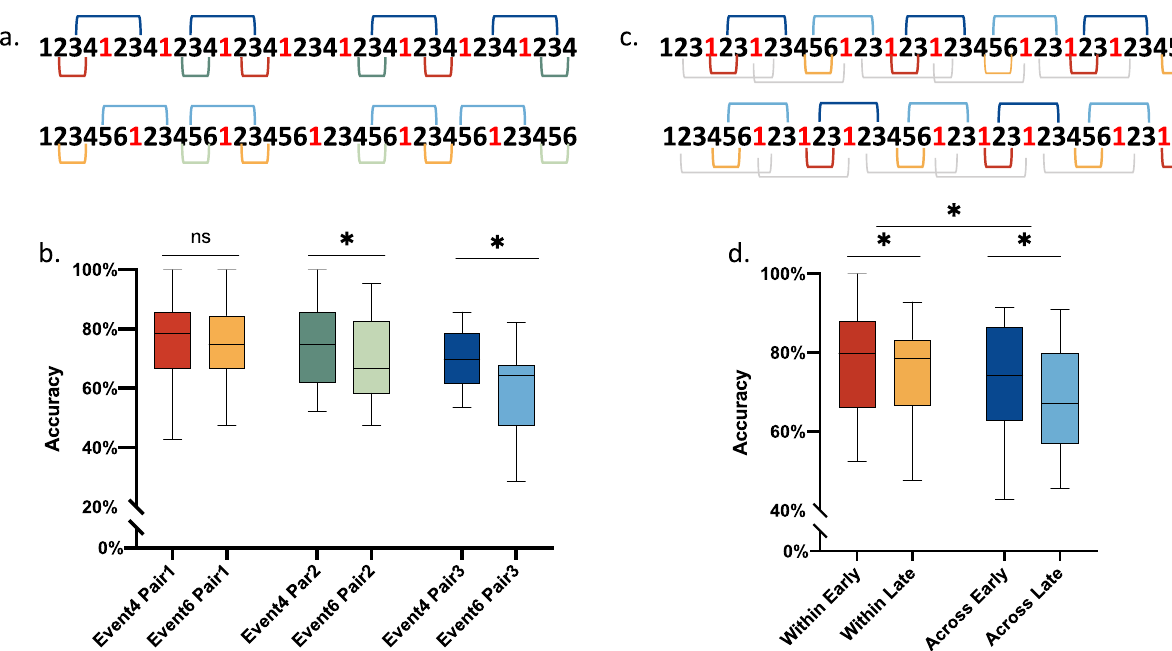
Fig. 3 Design and results of Experiment 3 & 4. a Schematic diagram of the task in Experiment 3. Two conditions were tested: one with events containing four items (Event 4) and the other containing six items (Event 6). Three matched pair types were tested: Pair type 1 marked by the red and yellow square brackets, Pair type 2 marked by green and light green square brackets and Pair type 3, marked by blue and light blue square brackets in the two conditions. b Box plots of group averaged temporal order memory for the three pair types ( n = 32). No signi fi cant difference was found between the Event 4 condition and the Event 6 condition for pair type 1 (t(31) = 0.06437, p = 0.9491, two-sided, q = 0.3322, FDR corrected for multiple comparisons); however, TOM was signi fi cantly better for the Event 4 than for Event 6 condition for both pair type 2 (t(31) = 2.334, p = 0.0262, two-sided, q < 0.05, FDR corrected) and pair type 3 (t(31) = 3.93, p < 0.001, two-sided, q < 0.05, FDR corrected). c Schematic diagram of the task in Experiment 4. Two sequence types were tested containing the same number of event boundaries but segmented differently, e.g., 336336 … vs. 633633 … items per event. Three pair types were tested: within-event pairs taking earlier and later local positions (matched by absolute list positions) denoted by the red and yellow square brackets (short for Within Early and Within Late respectively). Across-event pairs taking earlier and later local positions (matched by absolute list positions) denoted by the blue and light blue square brackets (short for Across Early and Across Late respectively). Across-event pairs with a longer lag than pairs marked by blue and light blue square brackets, are marked by light grey square brackets. d. Box plots of group averaged temporal order memory for within and across- event pairs taking earlier and later positions shown in Fig. 3c ( n = 30). TOM was signi fi cantly better for within vs. across-event pairs (F(1,29) = 8.217, p = 0.0076, η 2 = 4.657%), and for early vs. late pairs (F(1,29) = 8.933, p = 0.0057, η 2 = 2.503%). Planned contrasts further con fi rmed that TOM was signi fi cantly better for earlier vs. later pairs for both pair types (for within event pairs: t(29) = 2.256, p = 0.0318, two-sided, q < 0.05, FDR corrected; for across-event pairs: t(29) = 3.839, p < 0.001, two-sided, q < 0.05, FDR corrected). The boxes show the inter-quartile range (IQR) and the median. Whiskers in box plots represent the minimum and maximum in the dataset. The asterisk (*) represents statistical signi fi cance at p < 0.05. Numbers in red denote event boundaries in Fig. 3a, c. Source data are provided as a Source Data fi